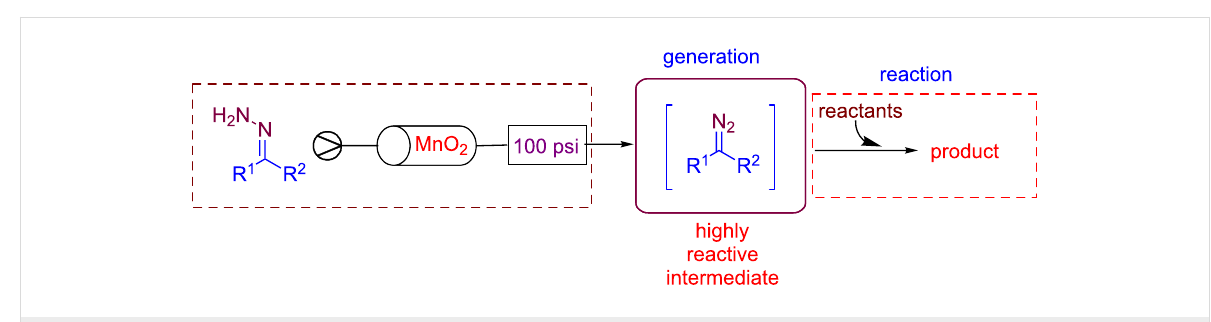
Scheme 17: Synthetic use of flow-generated diazo compounds.